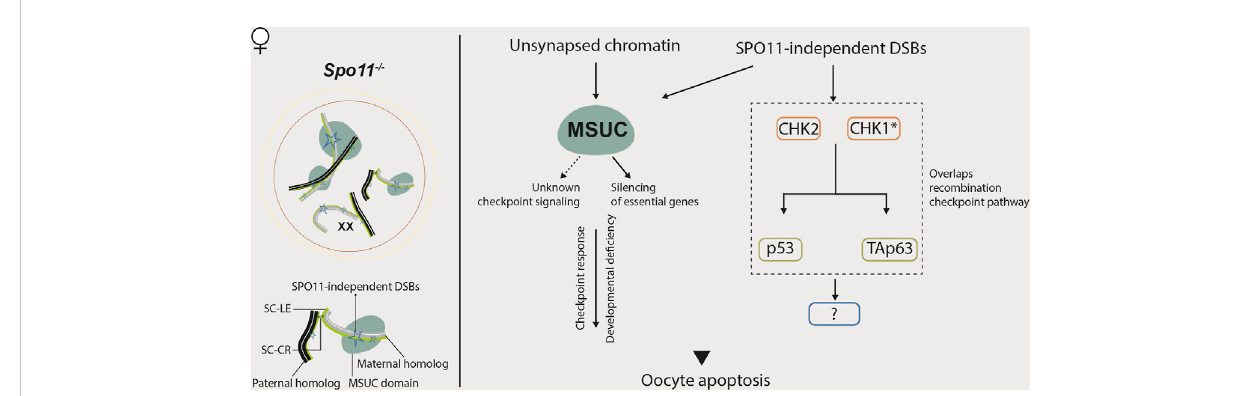
Meiotic response to asynapsis in female. Several mechanisms are proposed to be responsible for eliminating Spo11 − / − oocytes. MSUC might trigger an unknown checkpoint signaling pathway in these oocytes or silence essential genes for development, leading to oocyte apoptosis. In parallel,